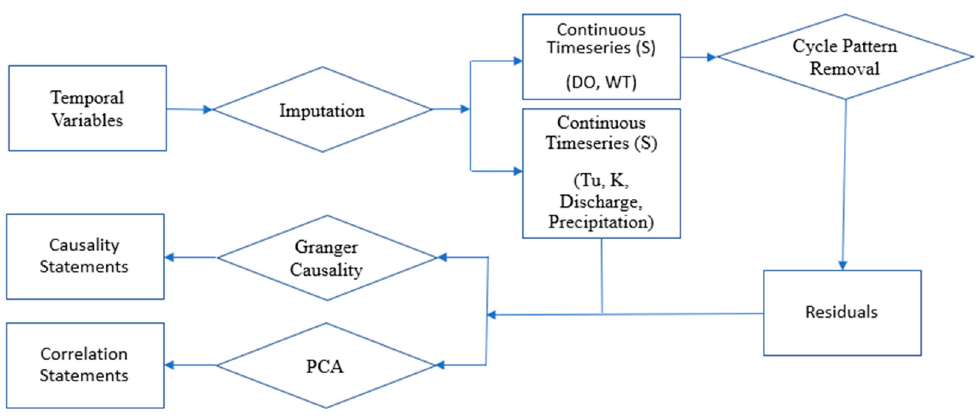
Figure 2. Methodology flowchart. The rectangular shapes represent data and the diamond shapes represent processes.